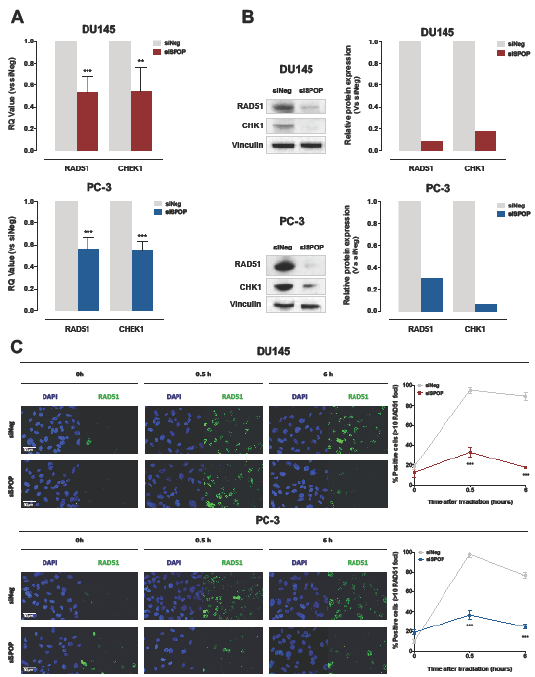
Figure 6. SPOP knockdown impairs HR via RAD51 and CHK1 downregulation. ( A ) qRT-PCR detection of RAD51 and CHEK1 transcript levels in DU145 (upper panel) or PC-3 (lower panel) cells at 48 h upon siSPOP transfection, compared to controls, normalized to GAPDH. Data are reported as relative quantity (RQ) ± SD with respect to siNeg transfectants. ( B ) Western blot analysis and relative quantification of RAD51 and CHK1 protein levels in DU145 and PC-3 cells at 48 h upon siSPOP transfection. Vinculin was used as equal protein loading control. ( C ) Representative immunofluorescence microphotographs of nuclear RAD51 foci (cell nuclei: blue; RAD51 foci: green) in DU145 (upper panel) or PC-3 (lower panel) cells at 48 h upon transfection with siSPOP at 0, 0.5 and 6 h after exposure to 6 Gy irradiation and relative quantification, expressed as mean percentage of cells containing > 10 RAD51 foci at 0, 0.5 and 6 h after exposure to 6 Gy irradiation. Data are reported as mean ± SD values from three independent experiments. The level of significance was represented as ** p < 0.01, *** p < 0.001, Student’s t